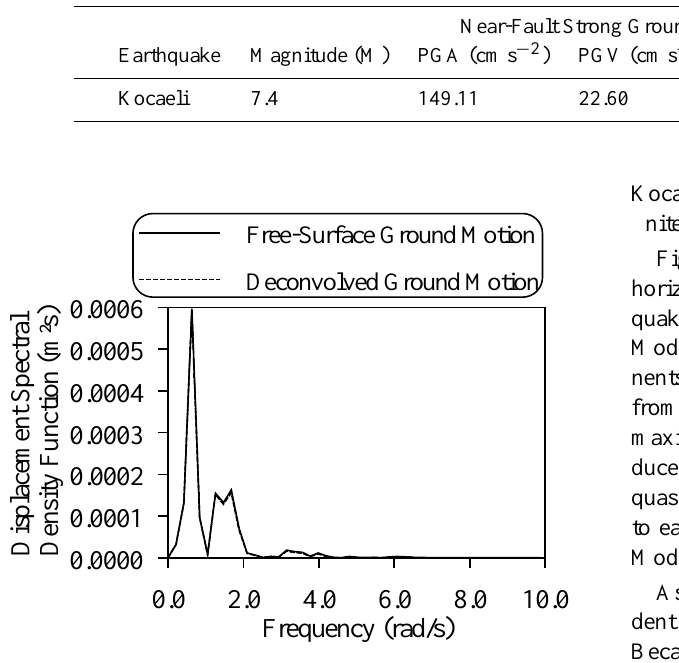
Fig. 8. Displacement spectral density function of the free-surface Fig.8. Displacement spectral density function of the free-surface and deconvolved ground for the 1999 and deconvolved ground for the 1999 Kocaeli Kocaeli earthquake